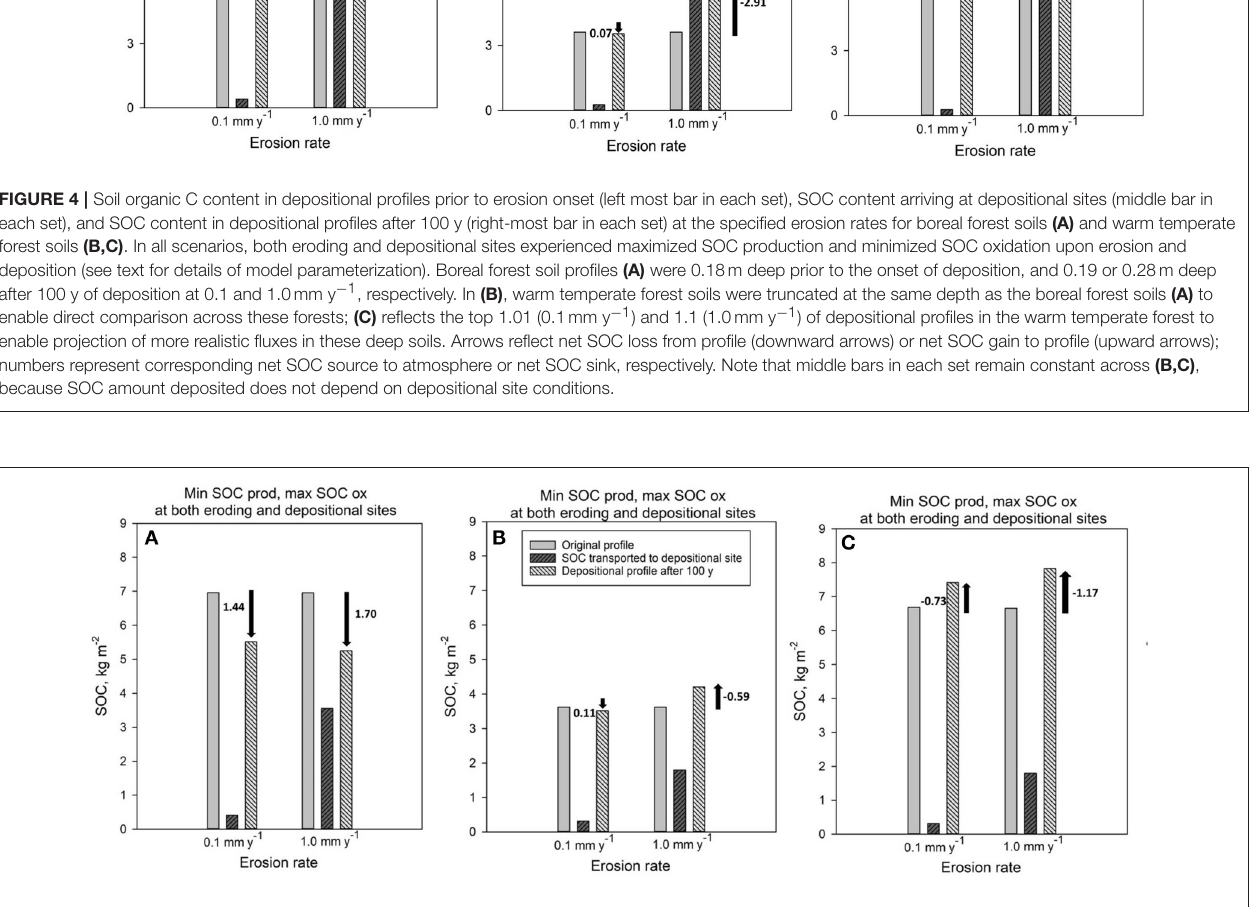
FIGURE 5 | Soil organic C content in depositional profiles prior to erosion onset (left most bar in each set), SOC content arriving at depositional sites (middle bar in each set), and SOC content in depositional profiles post-deposition (right-most bar in each set) at the specified erosion rates for boreal forest soils (A) and warm temperate forest soils (B,C) . In all scenarios, both eroding and depositional sites experienced minimized SOC production and maximized SOC oxidation upon erosion and deposition (see text for details of model parameterization). Boreal forest soil profiles (A) were 0.18m deep prior to the onset of deposition, and 0.19 or 0.28m deep after 100 y of deposition at 0.1 and 1.0mm y − 1 , respectively. Warm temperate forest soils were truncated at the same depth as the boreal forest soils in (B) to enable direct comparison across these forests; (C) considered the top 2m of depositional profiles in the warm temperate forest to enable projection of more realistic fluxes in these deep soils. Arrows reflect net SOC loss from profile (downward arrows) or net SOC gain to profile (upward arrows); numbers represent corresponding net SOC source to atmosphere or net SOC sink, respectively. Note that middle bars in each set remain constant across (B,C) , because SOC amount deposited does not depend on depositional site